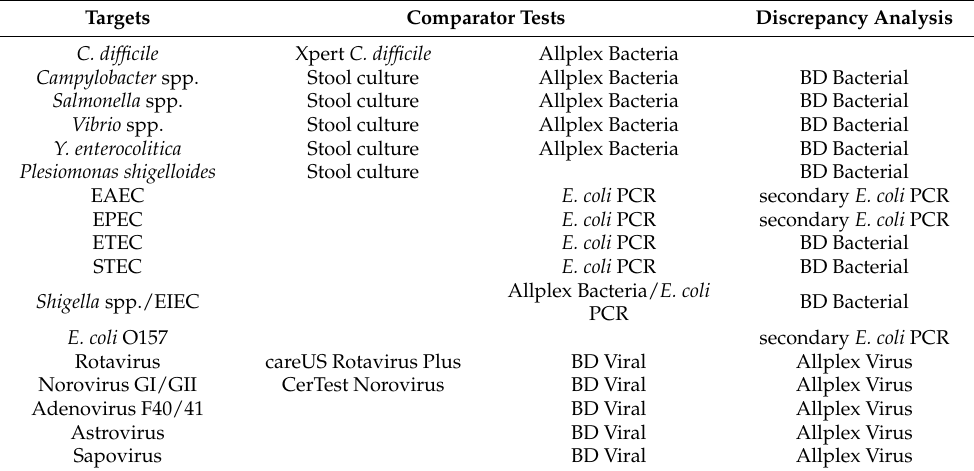
Table 1. Bacterial and viral pathogens targeted by the BioFire GI Panel, comparator tests, and discrepancy analysis